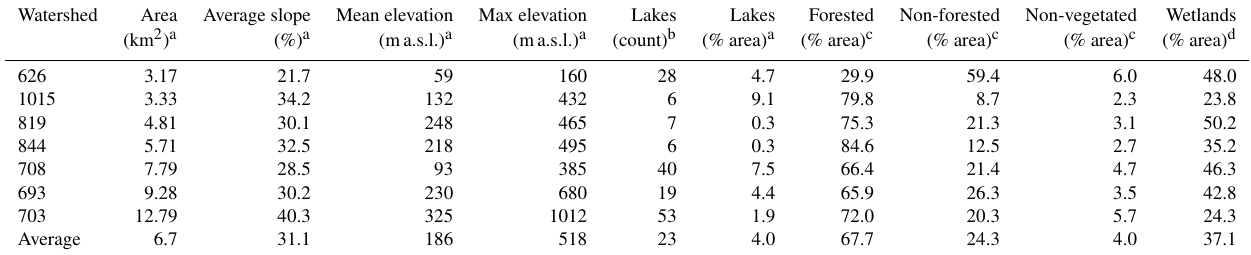
Table 1. Main characteristics of the seven gauged watersheds. Watershed Area Average slope Mean elevation Max elevation Lakes